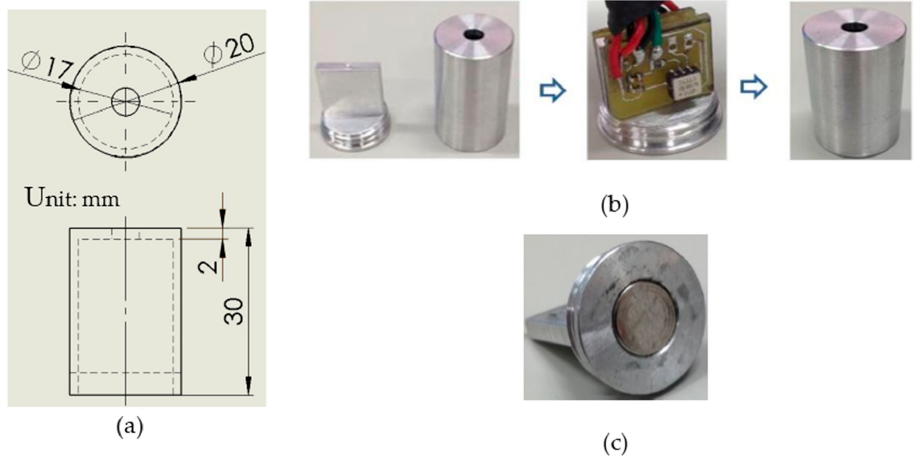
Figure 3. ( a ) The geometric design and dimension of the accelerometer housing; ( b )The assembly of